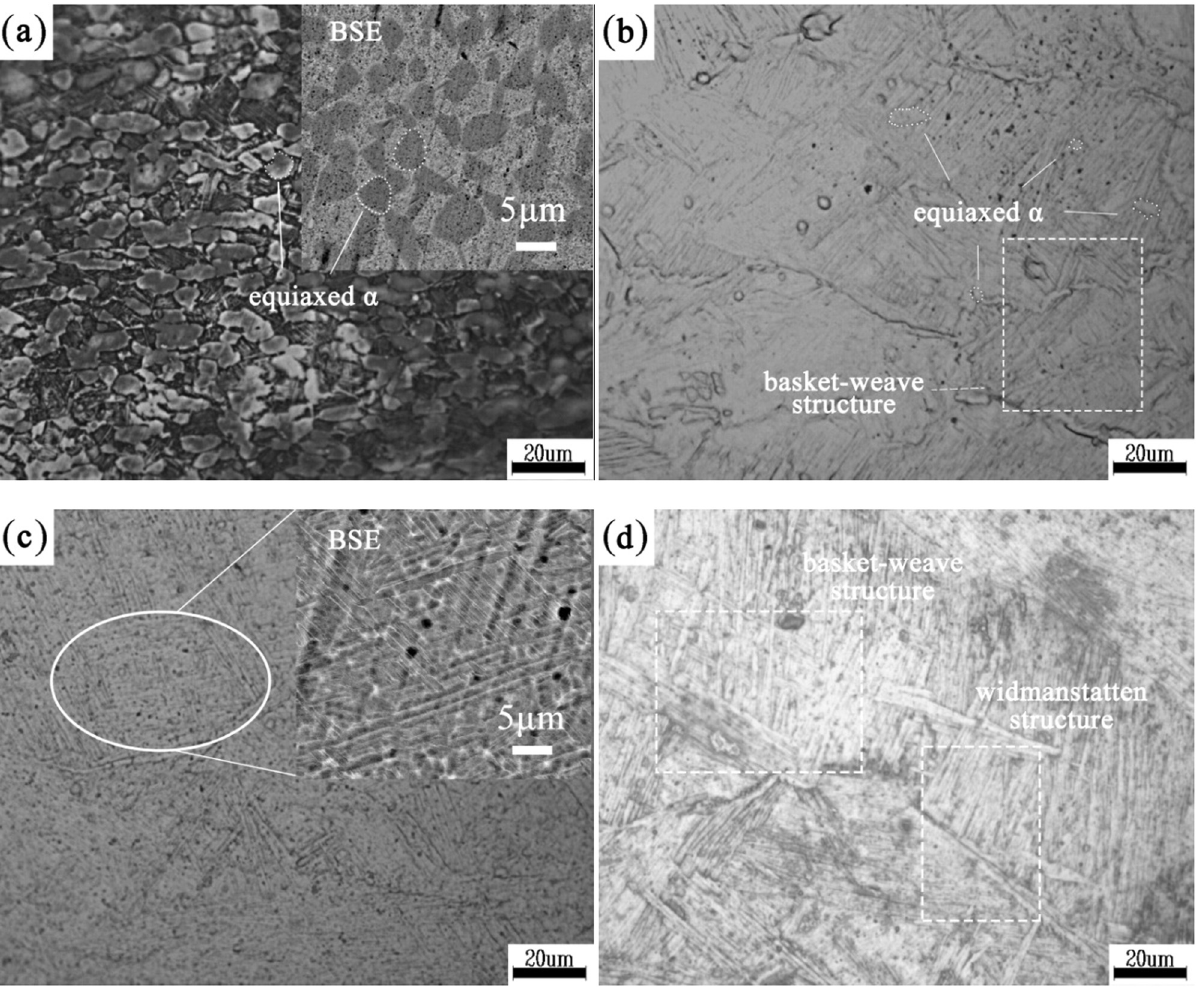
Figure 6: The OM and backscattered electrons of the samples after deformation at the strain rate of 0.001 s − 1 ( a ) T = 900°C; ( b ) T = 950°C; ( c ) T = 1,000°C and ( d ) T =